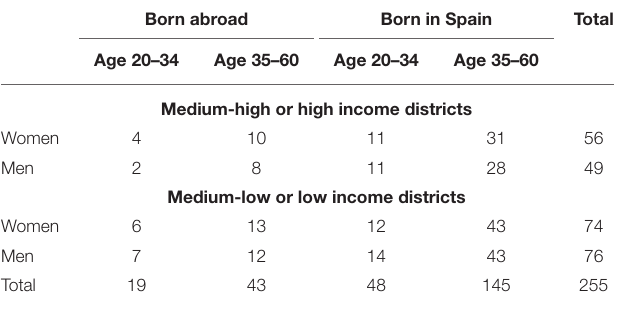
TABLE 1 | Characteristics of the PRESSED survey